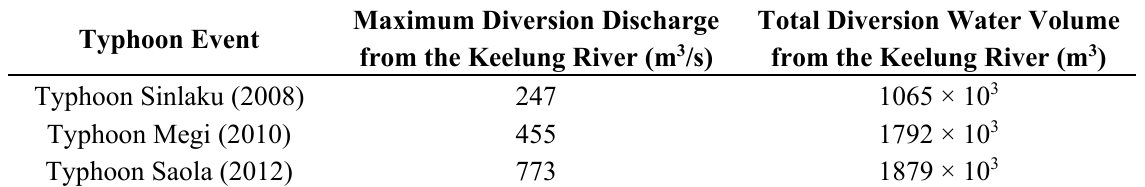
Table 1. Record of flood diversion for three typhoon